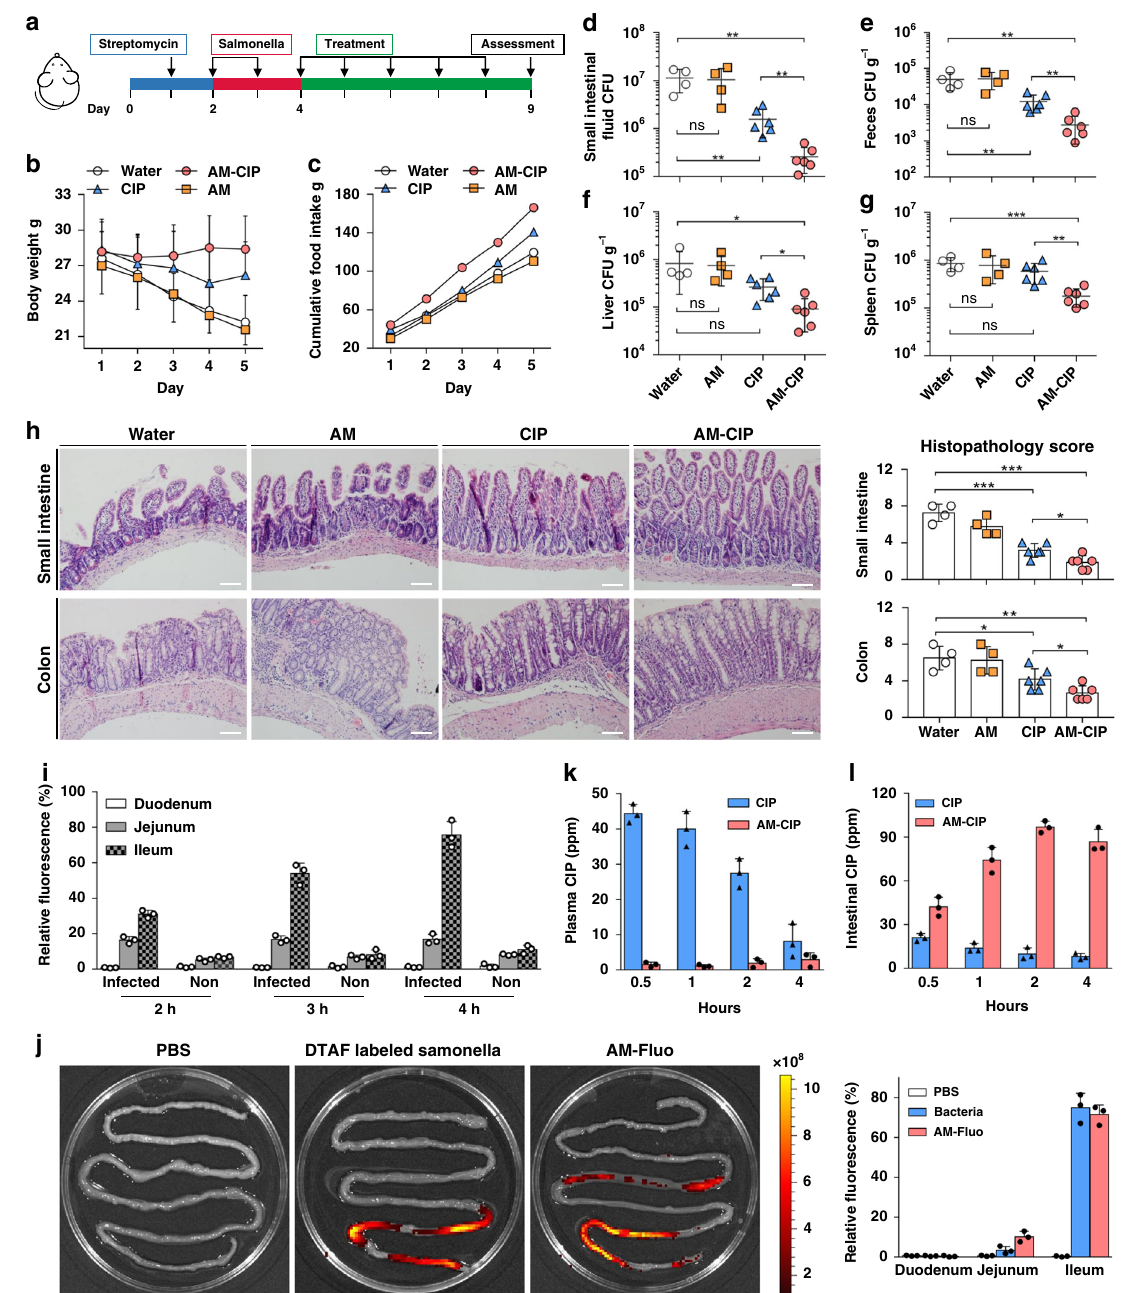
Fig. 2 Therapeutic ef fi cacy in acute intestinal infection model. a The study protocol including streptomycin pretreatment and S. typhimurium inoculation on mice, followed by the treatments [AM (100 mg kg − 1 ), CIP (10 mg kg − 1 ), or AM-CIP (110 mg kg − 1 ) daily]. b Body weight. n = 4 – 6 mice per group. c Cumulative food intake. n = 4 – 6 mice per group. Quanti fi cation of bacterial burden in the small intestine ( d ), feces ( e ), liver ( f ), and spleen ( g ) of infected mice with different treatments. h H&E stained sections of intestine tissues from infected mice after with individual treatments. Scale bar, 100 µ m. Histogram represents combined histopathology score ( n = 4 – 6 mice per group). i Fluorescent intensity of small intestines from normal or infected mice 2 h, 3 h, and 4 h after administration of Fluo-loaded AM vesicles ( n = 3 mice per group). j Fluorescence images of small intestines from infected mice 12 h after administration of PBS, 5-DTAF-labeled S. typhimurium or Fluo-loaded AM vesicles ( n = 3 mice per group). k , l Mean plasma or intestinal concentration of CIP following a single oral administration of AM-CIP (110 mg kg − 1 ) or CIP (10 mg kg − 1 ) in normal mice ( n = 3 mice per group). Data are shown as mean ± SD, and each dot represents one animal. A single asterisk indicate p-values of <0.05, double asterisks indicate p -values of <0.01, triple asterisks indicate p -values of <0.001, ns no statistical signi fi cance (two-tailed Student ’ s t -test). Source data are provided as a Source Data fi